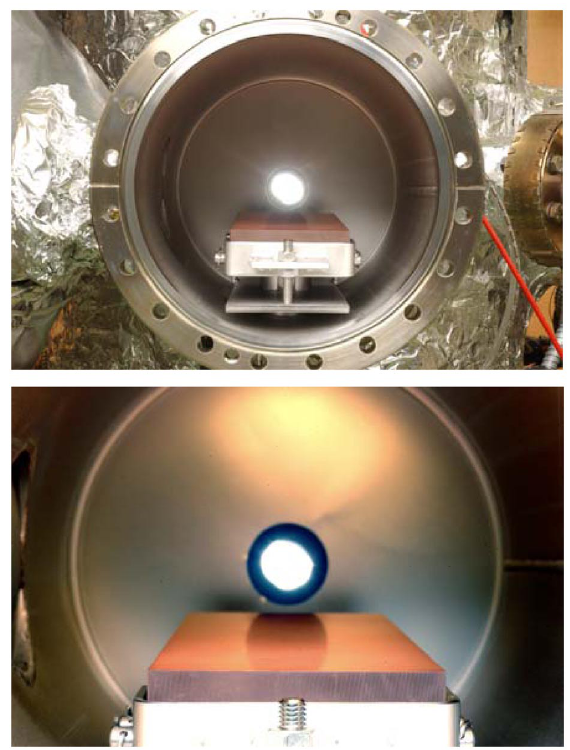
FIG. 2. (Color) Pictures of the inner part of one collimator chamber of the SPS desorption experiment. The aligned ( (cid:24) (cid:4) 35 mrad ) Cu = graphite collimator is shown in its ‘‘parking position,’’ i.e., 18.5 mm below the beam axis. The ion beam has to pass the centered conductance (diameter 30 mm), which is made of a vacuum fired 100 (cid:4) m thick 316 LN stainless steel foil.